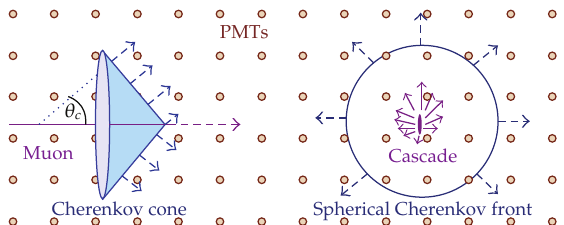
Figure 8: Contrasting Cherenkov light patterns produced by muons (left) and by showers initiated by electron and tau neutrinos (right) and by neutral current interactions. The patterns are routinely referred to as tracks and cascades (or showers). Cascades are produced by the radiation of particle showers of dimension of tens of meters, that is, an approximately point source of light with respect to the dimensions of the detector. At PeV energies, 𝜏 leptons travel hundreds of meters before decaying, producing a third topology, with two cascades, one when the 𝜏 interacts and the second when the 𝜏 decays [76]. This is the “double bang”